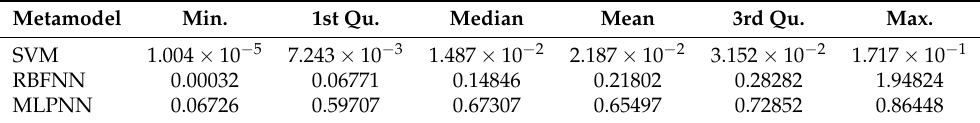
Table 2. Metamodeling error in mass computation.